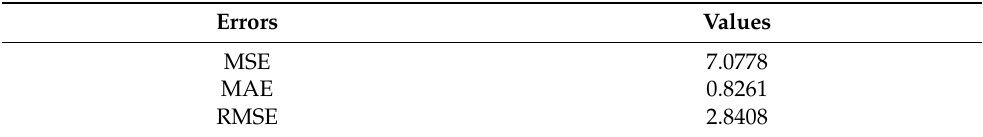
Table 9. Prediction errors of solar radiation using the ARMA (4,4) model.